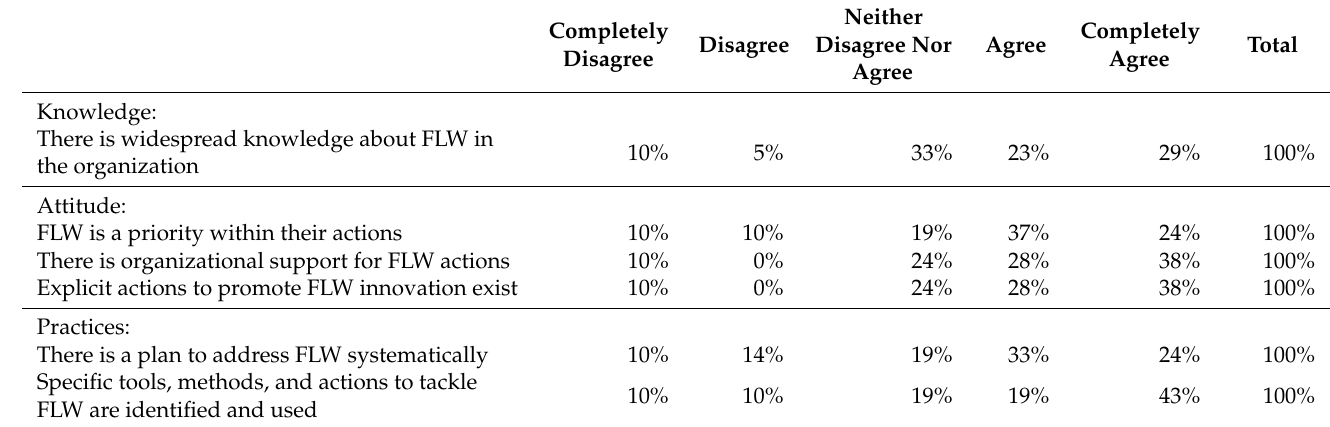
Table 3. Knowledge, attitudes, and practices from stakeholders to address